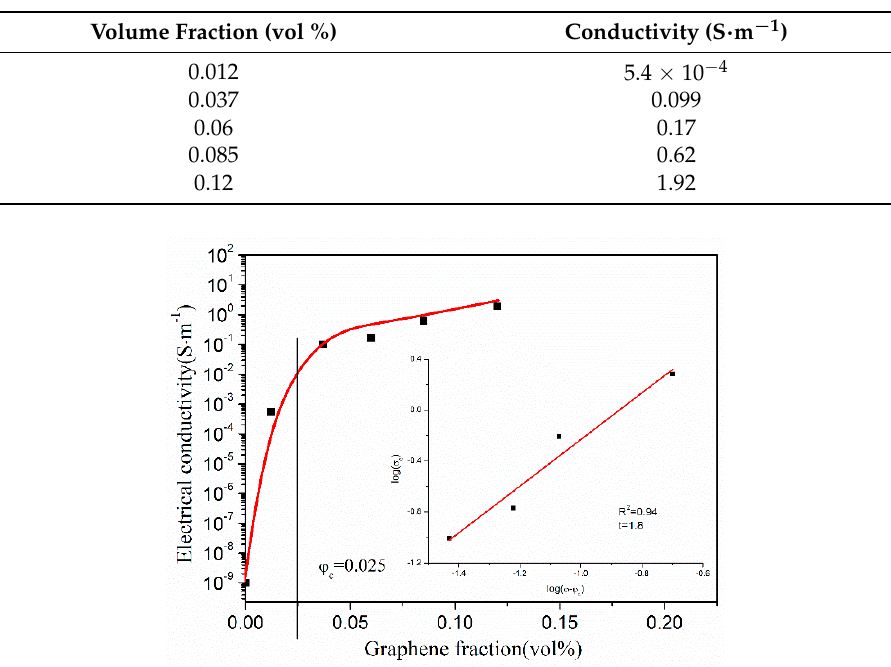
Figure 11. The conductivity of as-prepared modified GE/EP composites. Inset: log-log plot of illustrating the percolation model. Table 2. The conductivity of modified GE/EP composites with different volume fractions of modified GE according to the conversion of the mass.